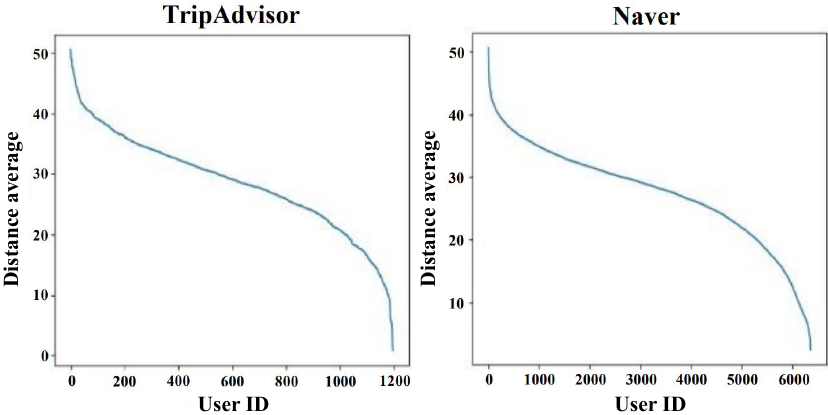
Figure 3. Average of distance (km) to POIs visited for each